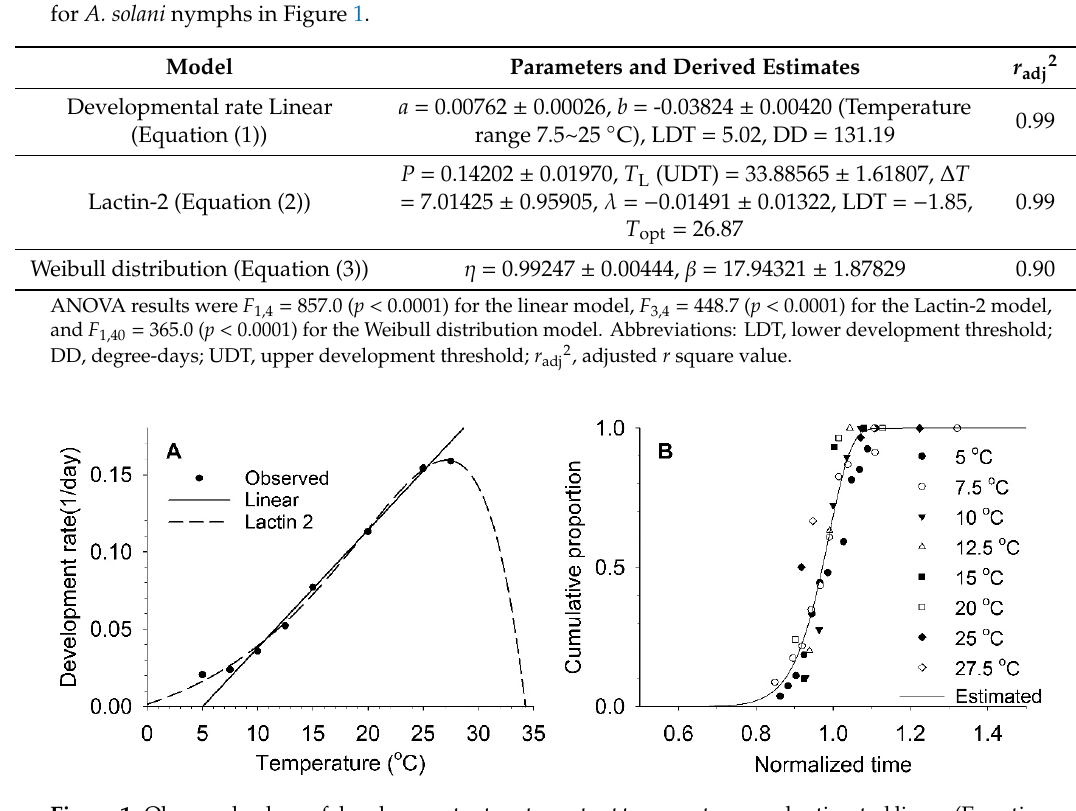
Figure 1. Observed values of development rates at constant temperatures and estimated linear (Equation (1)) and nonlinear Lactin-2 model (Equation (2)) curves between temperature and development rates ( A ), and Weibull distribution curve (Equation (3)) for development completion ( B ) in A. solani nymphs. Table 3. Parameters and values derived from the development rate models and the distribution model for A . solani nymphs in Figure